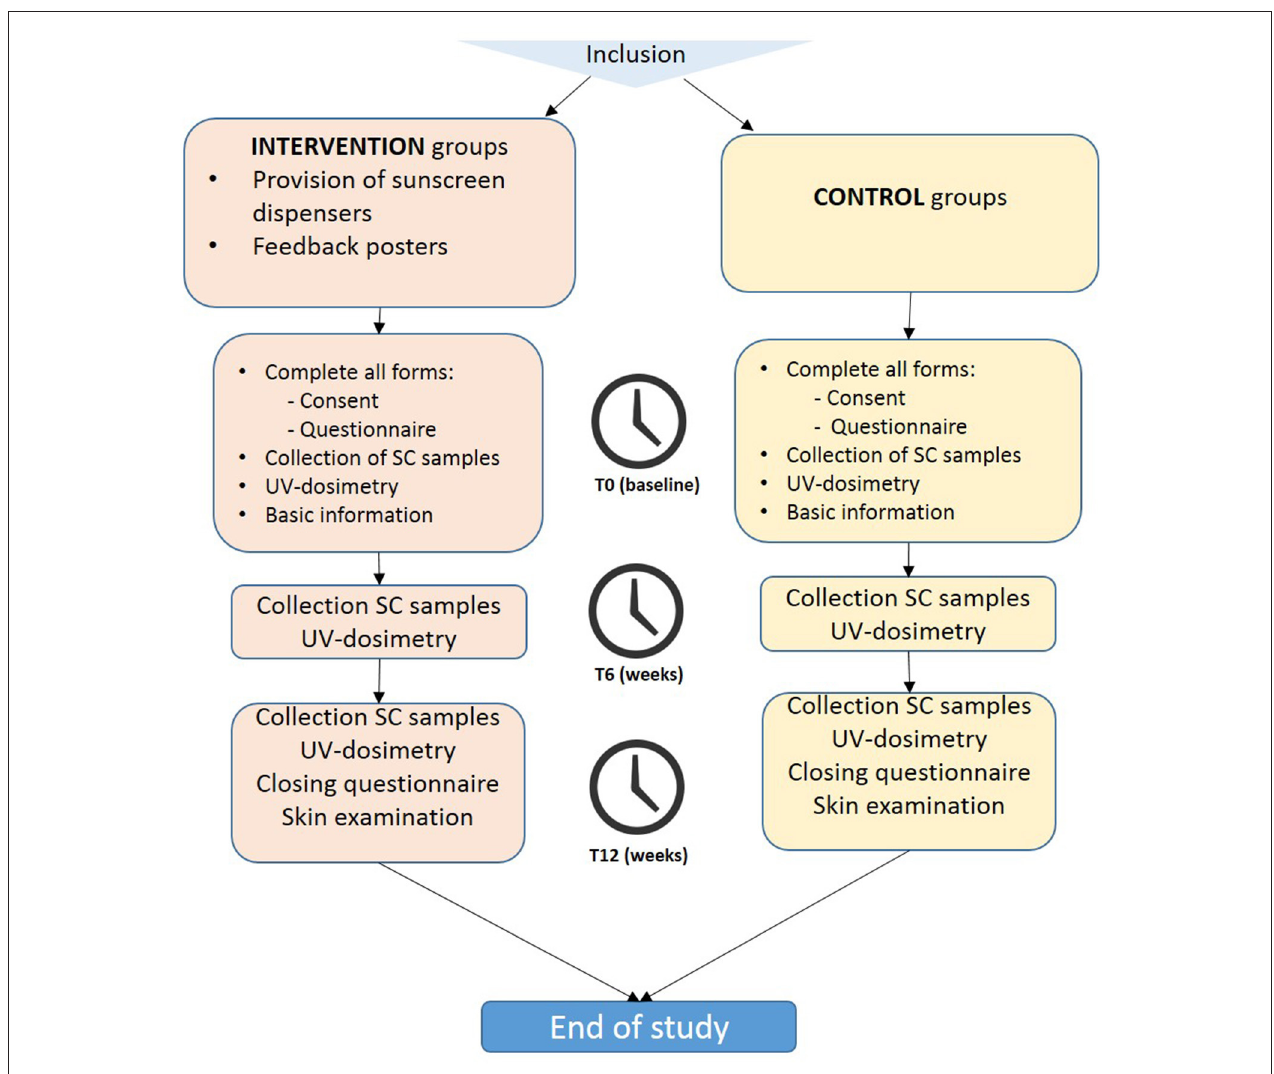
FIGURE 1 | Flowchart of the study